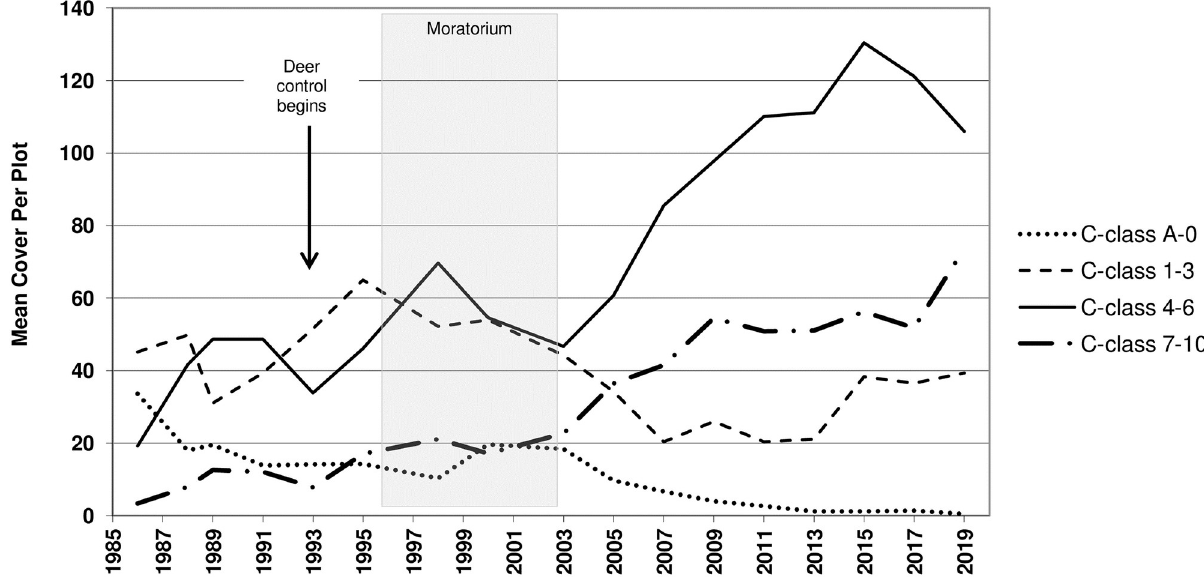
Fig 6. Mean cover per plot of species within each of four conservatism classes. Arrows represent the onset of deer culling, which continued thereafter. Shaded area represents the vegetation management moratorium years.